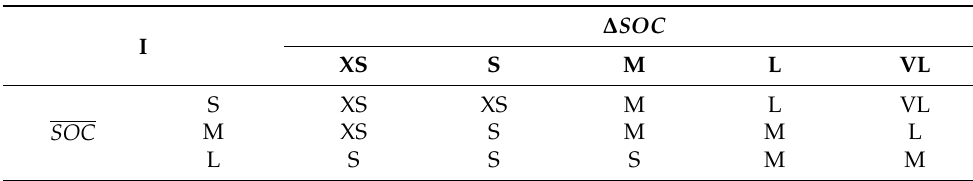
Table 1. Input and output fuzzy rules.